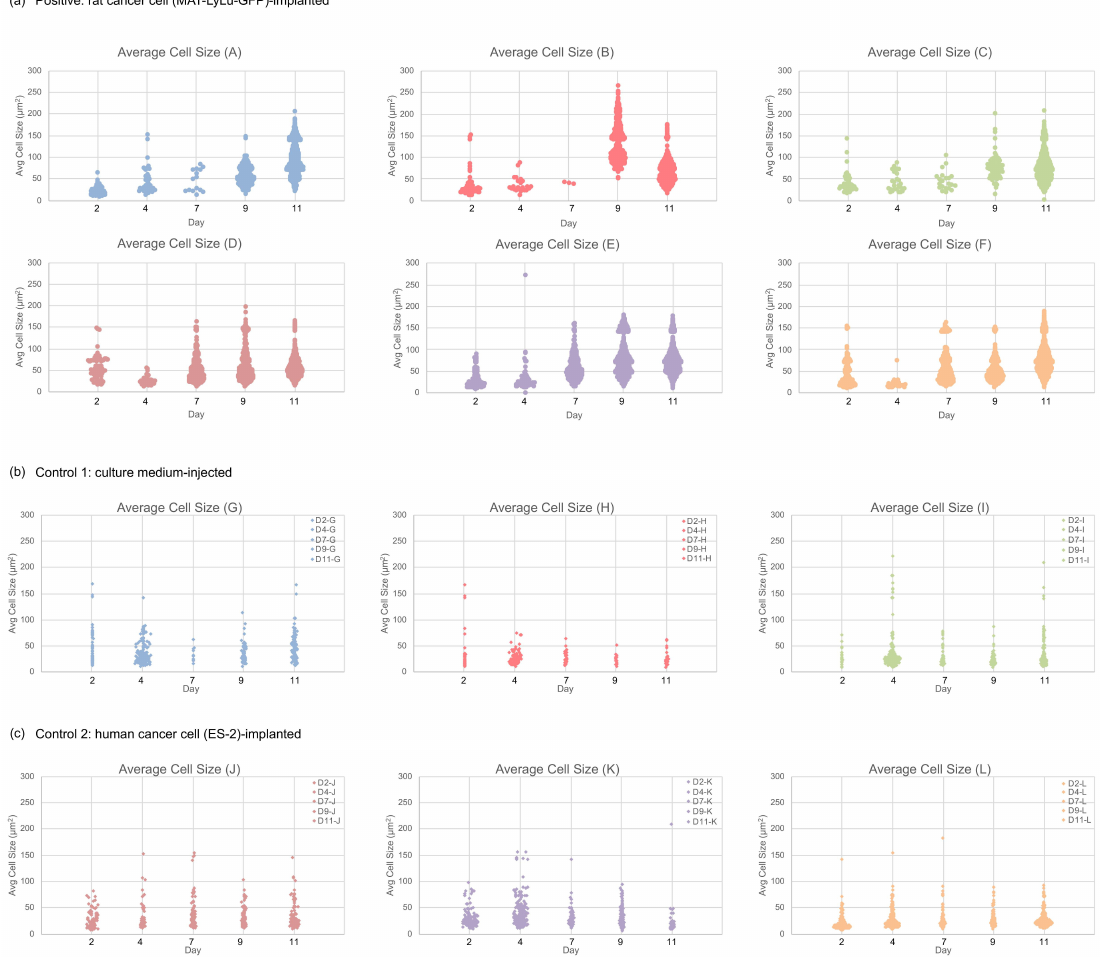
Figure 13. Time-course change of average size distribution of cells in positive ( a ), control 1 ( b ), and control 2 blood ( c ). Each value represents 2, 4, 7, 9, or 11 days after the implantation of rat cancer cells ( A – F , six positive rats), culture medium ( G – I , three rats of control 1), or human cancer cells ( J – L , three rats of control 2). For each case, the x -axis represents the population at each average cell or cell cluster size on the y -axis.